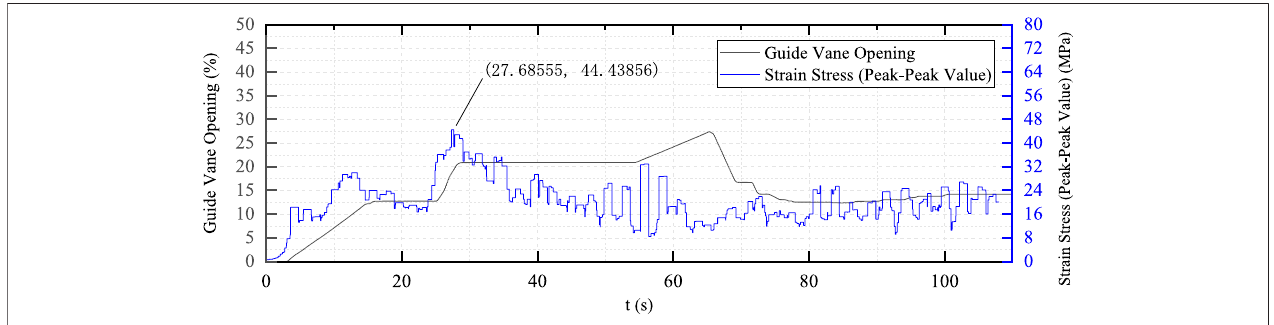
FIGURE 16 | The dynamic strain – stress curve with the guide vane opening (optimized control mode).